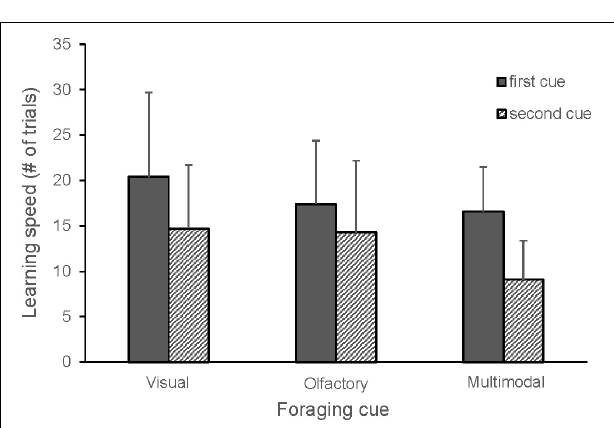
FIGURE 2 | Learning speed in great tits for the first and the second visual ( n = 16), olfactory ( n = 24) and multimodal ( n = 24) foraging cues. Mean number of trials and standard deviation are shown. The cues tested: visual (blue, yellow), olfactory (MeSA, MeJA, vanilla), multimodal (blue + MeSA, blue + MeJA, blue + vanilla, yellow + MeSA, yellow + MeJA, yellow + vanilla, green + MeJA). Thirty birds each learned two cues and a single bird learned five cues. Learning speed for the second cue was significantly lower (GLMM, p < 0.0001), with an additional tendency for lower learning speed of second multimodal compared to olfactory cues (GLMM, p = 0.06).